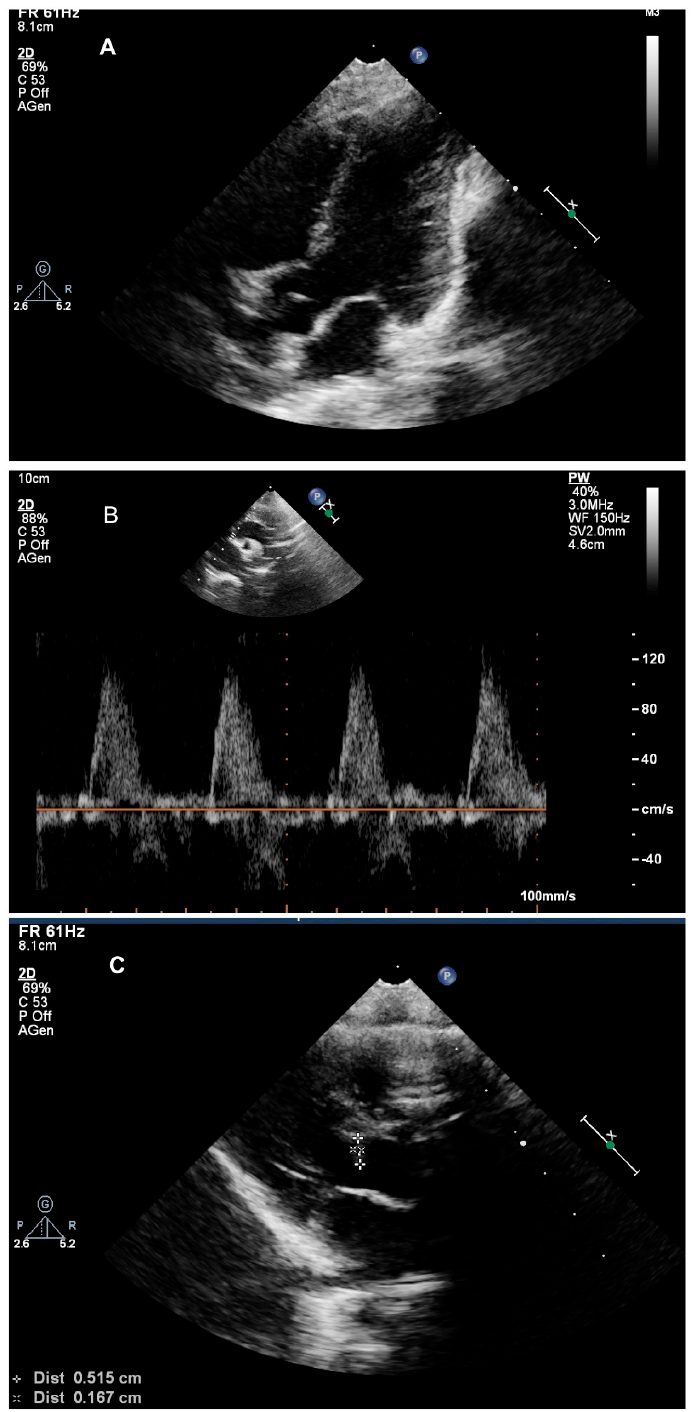
Figure 2. Echocardiogram after 1 week of Everolimus treatment. Panel ( A ) : Disappearance of the left ventricle rhabdomyomas; Panel ( B ) : Normal transaortic gradient; Panel ( C ): Marked reduction of the subaortic